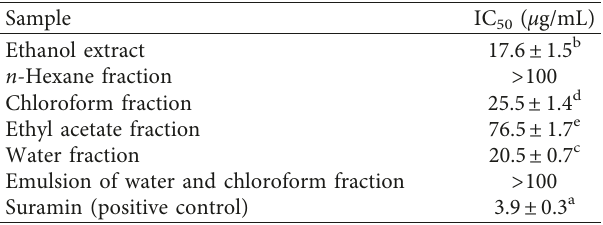
Each value represents mean ± S.E.M. of four determinations. Differ- ent characters (a, b, c, d, and e) indicate significant differences among the compared means which in the same treatment group at p < 0 .